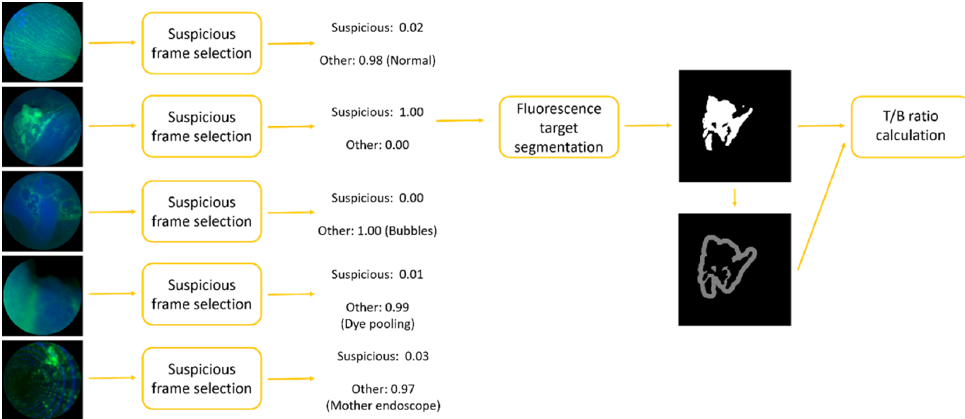
Figure 1. Overall CAD pipeline for automatic and real-time T/B calculation with two steps: (1) suspicious frame selection model and (2) fluorescence target segmentation model.